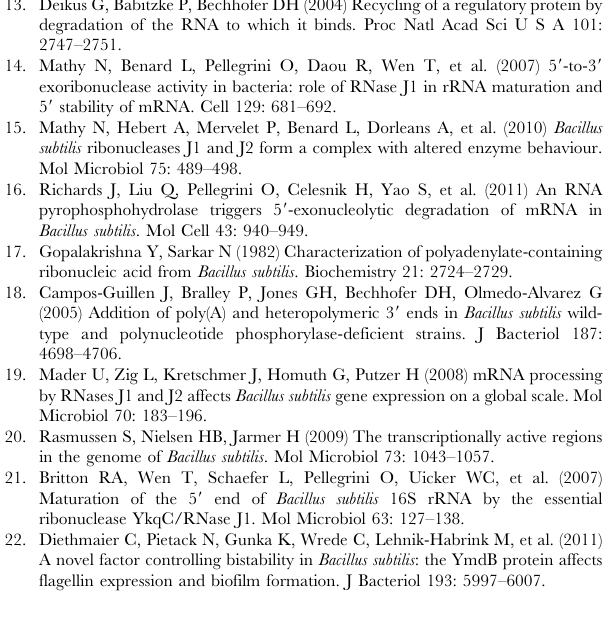
under-represented categories in orange; reference values for